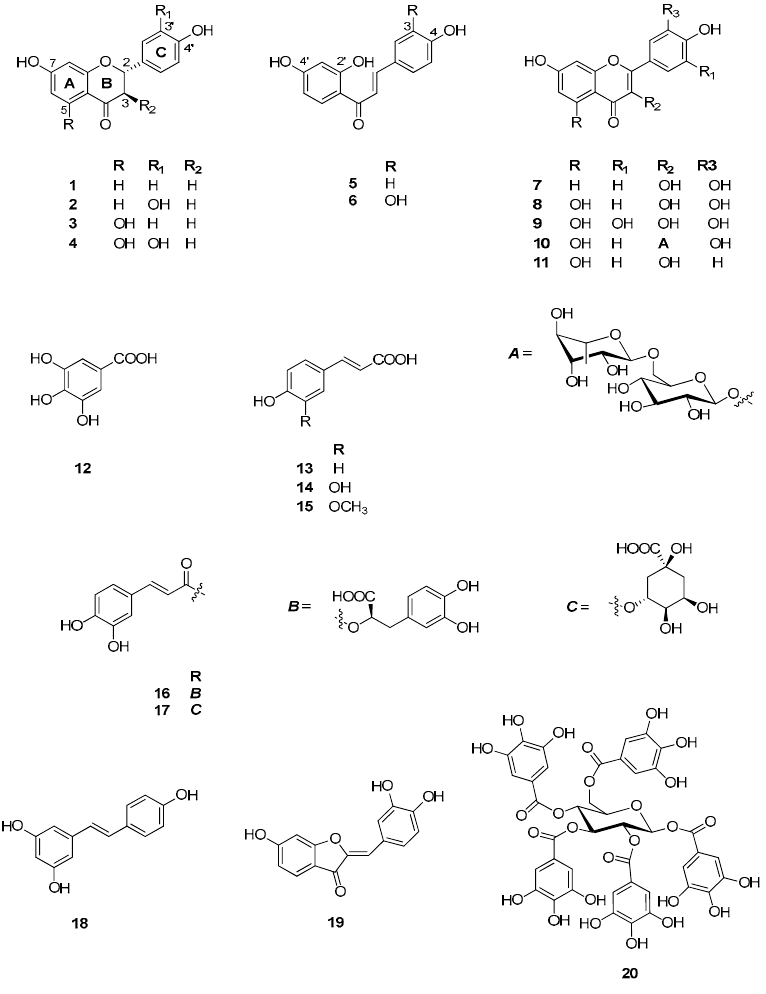
Figure A1. Chemical structures of compounds 1 – 20 isolated from C. coggygria .